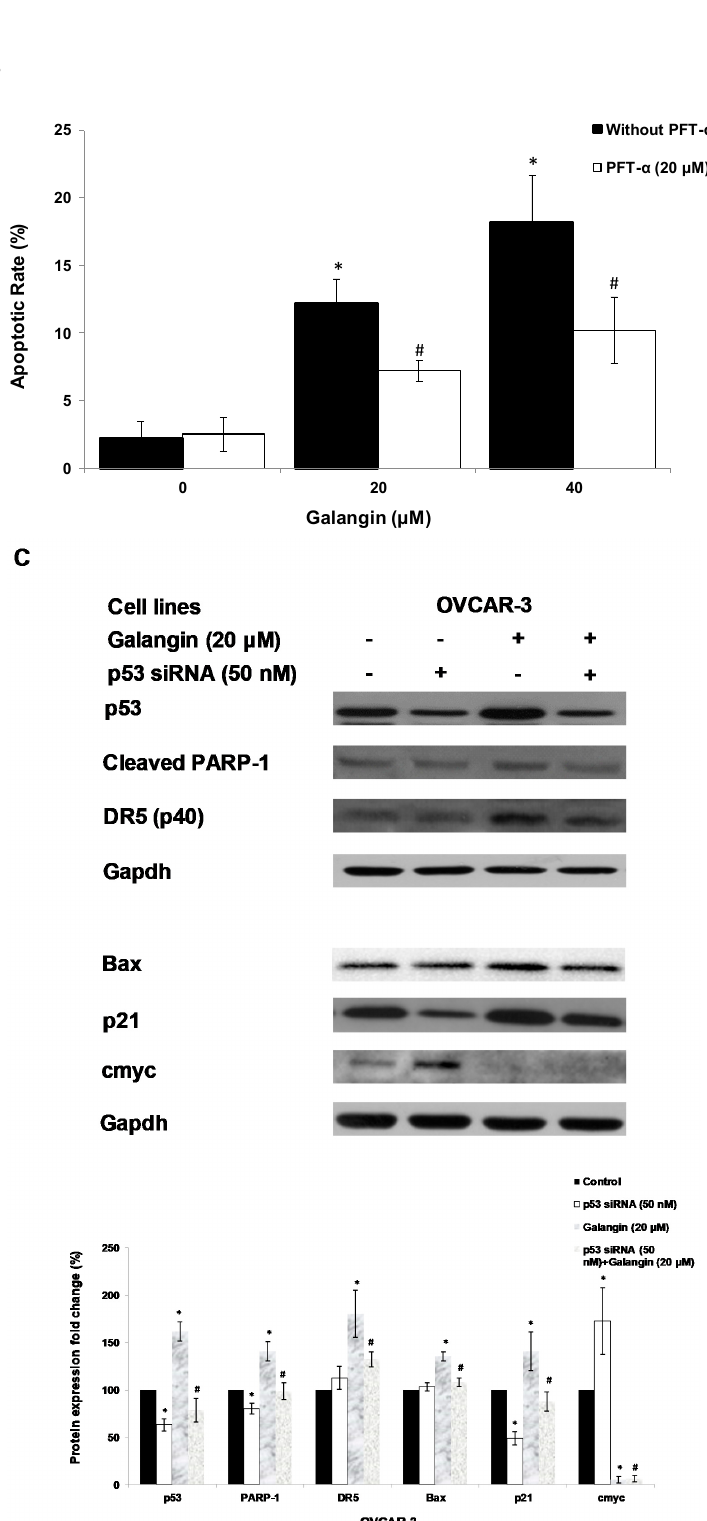
Figure 6. The key protein p53 in the regulation of the galangin-induced apoptosis in A2780 / CP70 and OVCAR-3 cells. ( A ) Galangin up-regulated p53 and p21 protein expressions, and down-regulated cmyc, p-Akt and p-p70S6K protein levels. ( B ) OVCAR-3 cells were treated with p53 inhibitor PFT- α and galangin for 24 h. The apoptotic rates were measured using a fluorescence microscope (ZEISS) after Hoechst 33,342 staining. ( C ) The galangin-increased levels of cleaved PARP-1, matured DR5, Bax and p21 proteins were abrogated after knockdown of p53 protein. Protein bands were quantitated, normalized to corresponding Gapdh bands and expressed as percentages of the control. * p < 0.05 as compared to the control; # p < 0.05 as compared to the galangin-treated